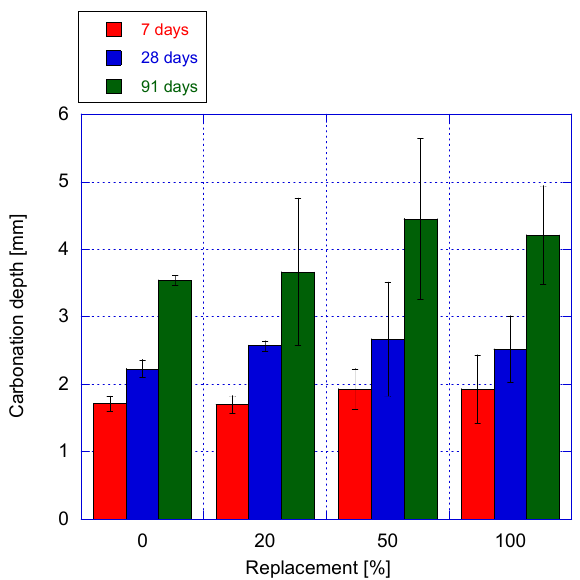
Figure 9. Carbonation depth for all mixes and ages.